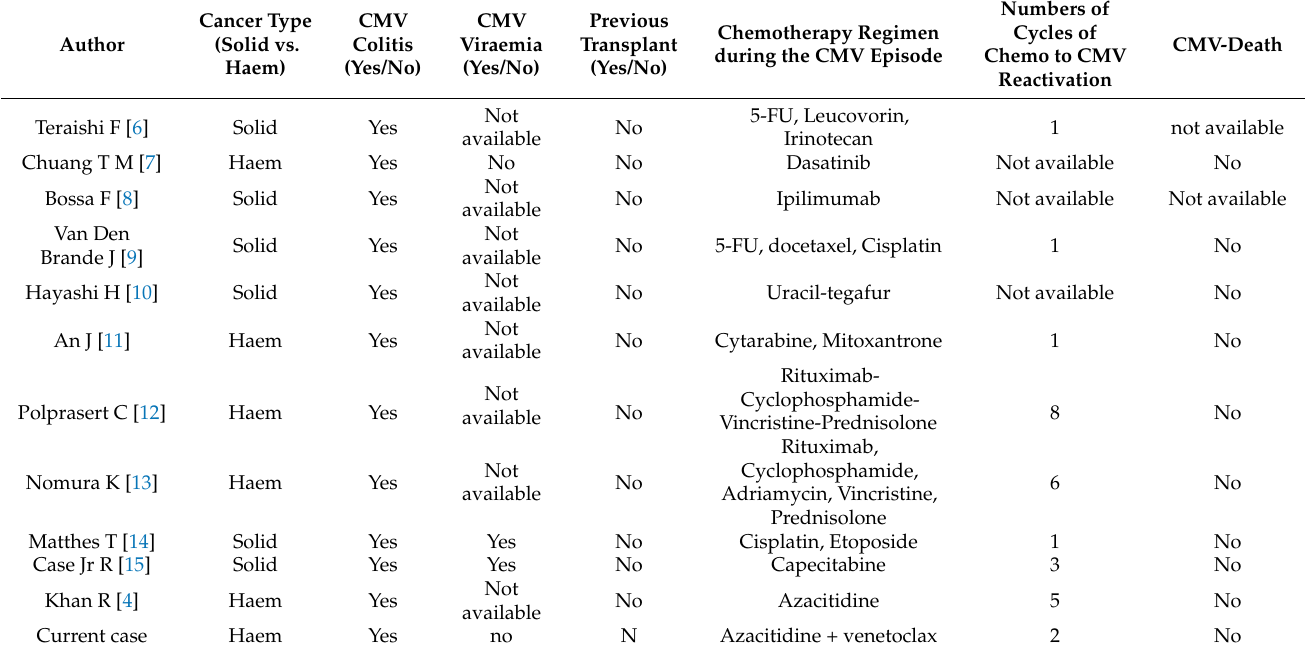
Table 1. Cases of CMV colitis arising post-chemotherapy.